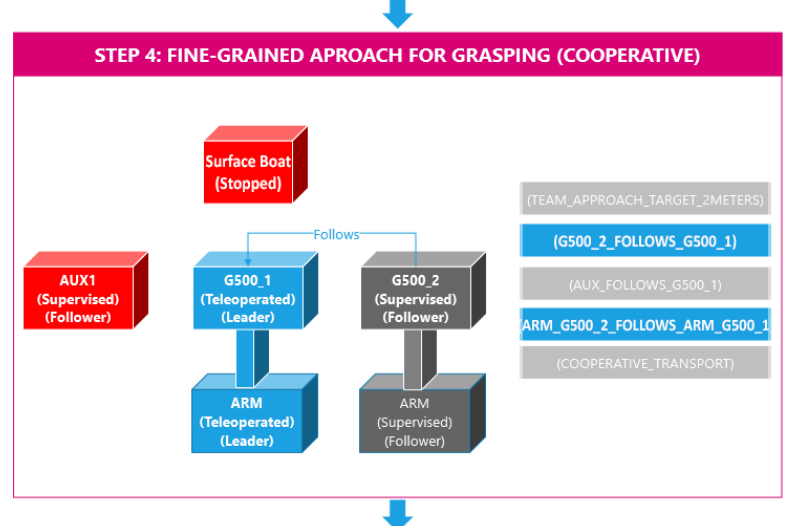
Figure 12. Cooperative robotics mission plan (step 4): once the two mobile manipulators face the grasping points, the cooperative behaviours are activated to make the second robot (including the arm) follow the leader to perform cooperative